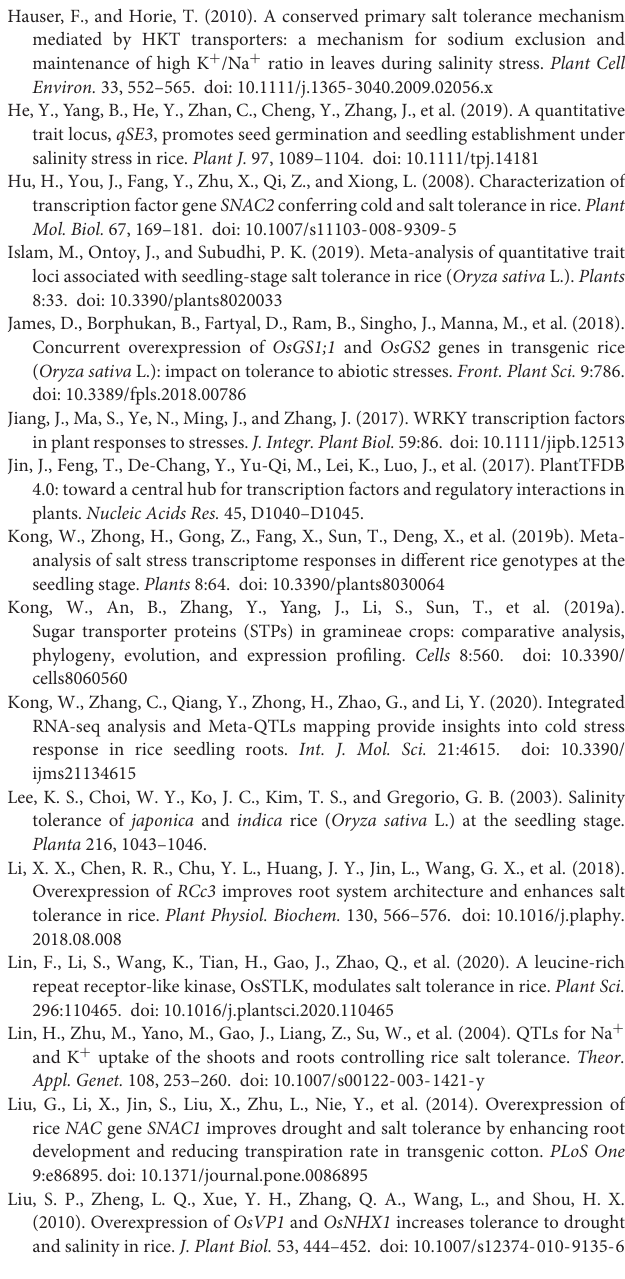
Supplementary Table 2 | Primers used in RT-PCR. Supplementary Table 3 | Differentially expressed genes (DEGs) in G2 with the opposite expressed profiles in two subspecies. Supplementary Table 4 | Meta-QTLs collected in this study. Supplementary Table 5 | Salt stress-related genes collected in this study. Supplementary Table 6 | RPY geng specific DEGs in Meta-QTLs. Supplementary Table 7 | Seventy known salt stress-related genes in G2 and G3. Supplementary Table 8 | RNA-seq results of five randomly selected